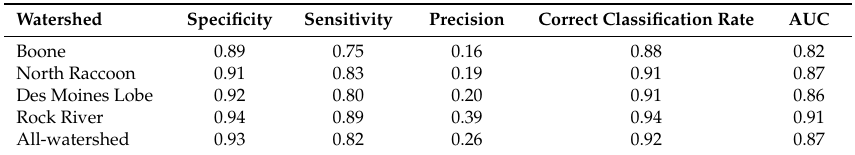
Table 3. The specificity (true negative rate), sensitivity (true positive rate), precision (rate at which features classified as a target feature were true target features), correct classification rate, and area under the receiver operator curve (AUC) of each